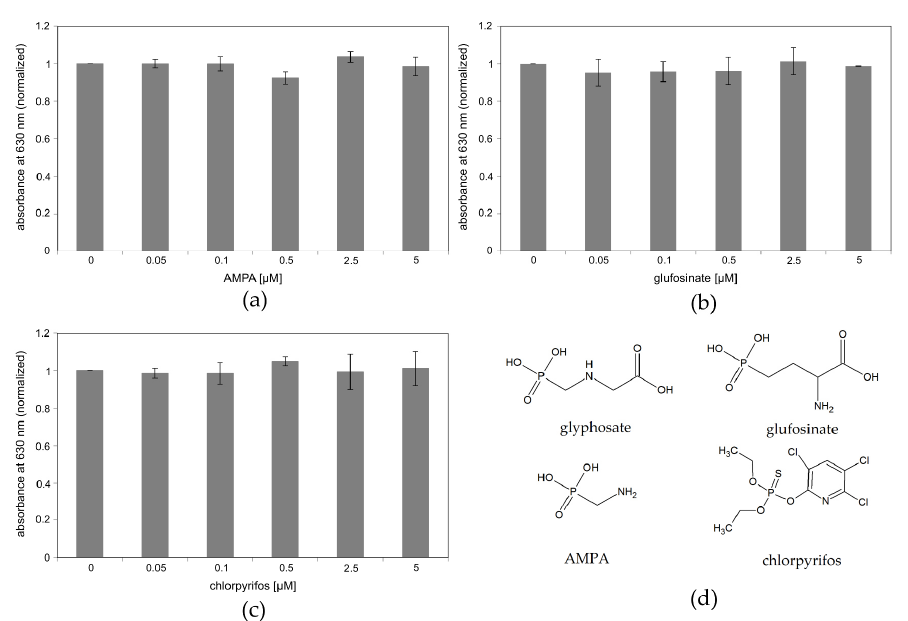
Figure 6. Measurement of cross-reactivity of the functionalized surface (1 µ M Ccg2_GS_EcEPSPS:5 µ M Ccg2, polystyrene) with the malachite green assay towards other pesticides. Results were normalized to the sample without glyphosate (0 µ M). Absorbance at a wavelength of 630 nm was determined using photometry. ( a ) Cross-reactivity for AMPA (aminomethylphosphonic acid), the primary degradation product of glyphosate. ( b ) Cross-reactivity for glufosinate, a member of amino acid-derived organophosphonate pesticides. ( c ) Cross-reactivity for the insecticide chlorpyrifos, belonging to the group of organophosphate pesticides. ( d ) Chemical structure of glyphosate and the three tested chemicals.